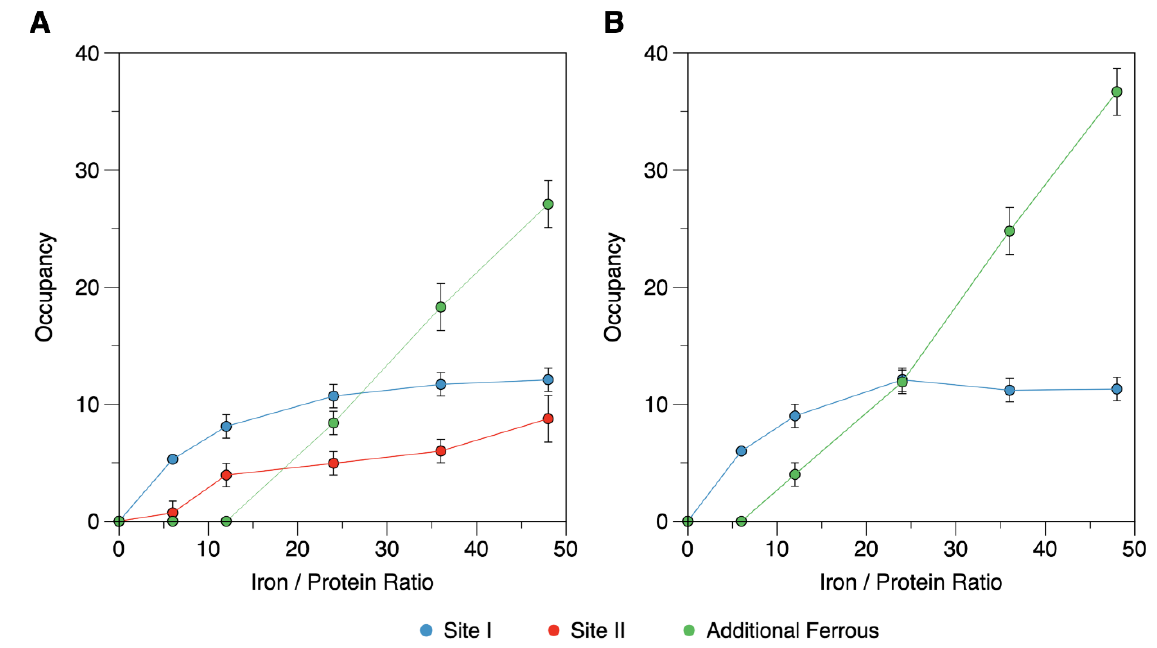
Figure 6. Occupancy of each type of ferrous iron in the iron-loaded Mössbauer samples of DgrDps WT ( A ) and ∆ N variant ( B ). The deconvolution of each spectrum into three different ferrous species allows the determination of the area percentage of each signal, which in turn can be used to calculate the stoichiometry of each type of ferrous signal per protein, considering the total amount of Fe per protein added. Site I, II, and additional ferrous species are in blue, red, and green, respectively.